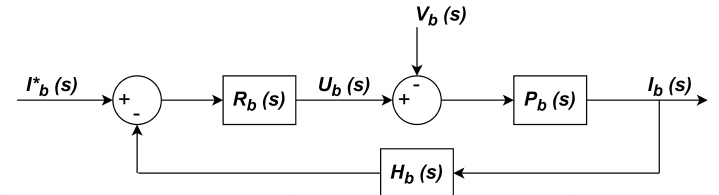
Figure 9. Closed-loop scheme for the control of the current of the EV battery I b ( s ) .